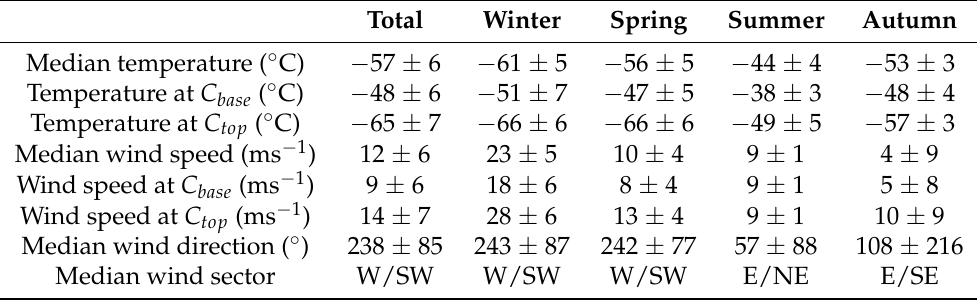
Table A2. Total and seasonal descriptive statistics of cirrus layer meteorological properties, including both COD regimes .